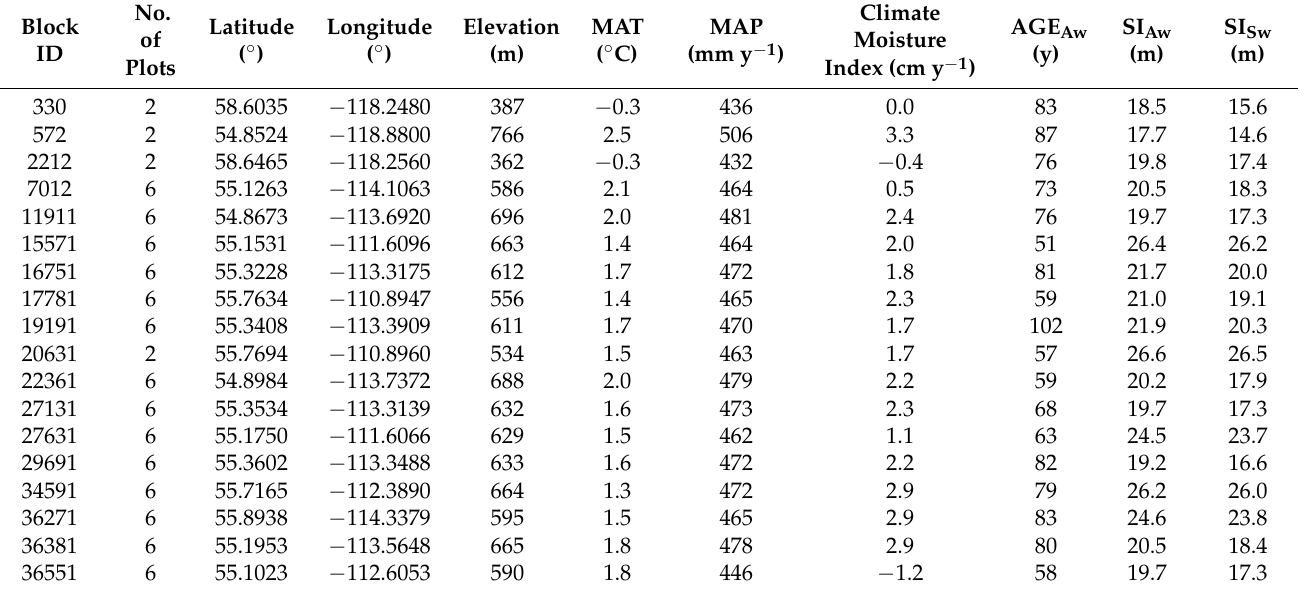
Table 1. Information for Strip Cut Understory Protection (SCUP) blocks used in this study. Aspen age (AGEAw) and site index (SI Aw ) were calculated using data from aspen in unharvested buffers, and spruce site index (SI sw ) was obtained using an aspen-to-spruce SI conversion model [21]; both represent tree height at a reference age of 50 years total age. Climate data were from ClimateNA version 6.11 for the 1981–2010 normal period. MAT = mean annual temperature; MAP = mean annual precipitation. Climate Moisture Index was calculated from model outputs of monthly temperature and precipitation following Hogg et al. (2013)